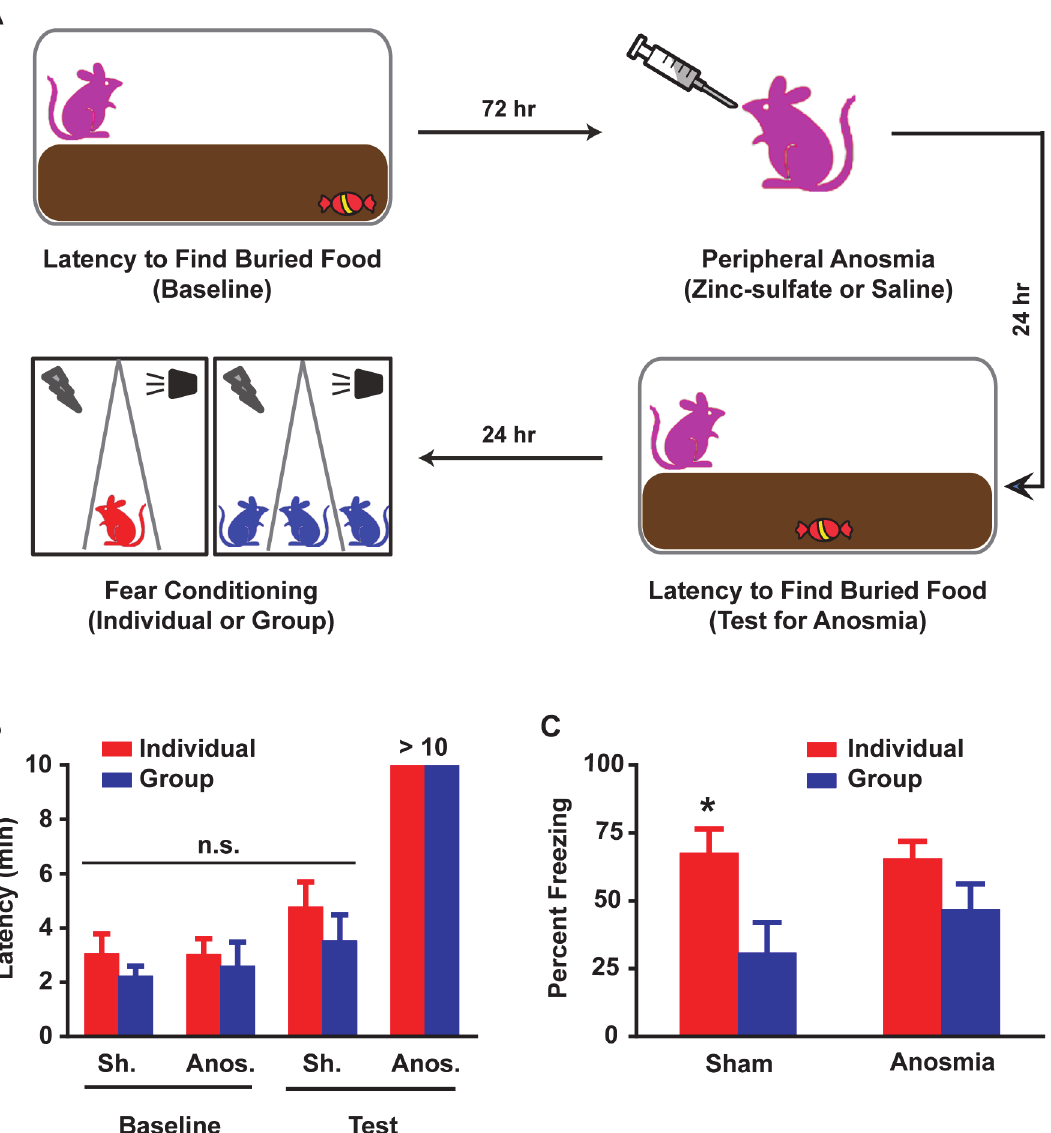
Fig 4. Olfactory signals among Group rats play a significant role in mediating conditioned fear reduction. (A) Schematic for zinc sulfate-induced peripheral anosmia. Rats are subjected to a buried food test. Seventy-two hours later, the rats undergo zinc-sulfate induced peripheral anosmia or sham procedure and the buried food test is repeated the following day to ensure intervention success. Twenty-four hours later, the rats are randomly assigned to Individual or Group conditioning. (B) Zinc sulfate induced peripheral anosmia that was characterized by > 10 min latency on the buried food test in both Individual and Group rats. All rats displayed similar baseline pre-treatment latencies which were also similar to sham Individual and Group rat latencies; two way ANOVA, p > 0.1. (C) Group rats with peripheral anosmia displayed freezing levels similar to those in Individual anosmic rats while sham Group rats maintained the fear reduction in comparison to sham Individual rats in a LTM test. Two-way ANOVA revealed an effect of conditioning (Individual or Group), F (1, 29) = 9.28, p < 0.01. Post-hoc tests revealed that this difference was exclusively driven by the sham rats (Individual vs Group), p < 0.05, but not anosmic rats (Individual vs Group), p > 0.1. Data presented as mean +